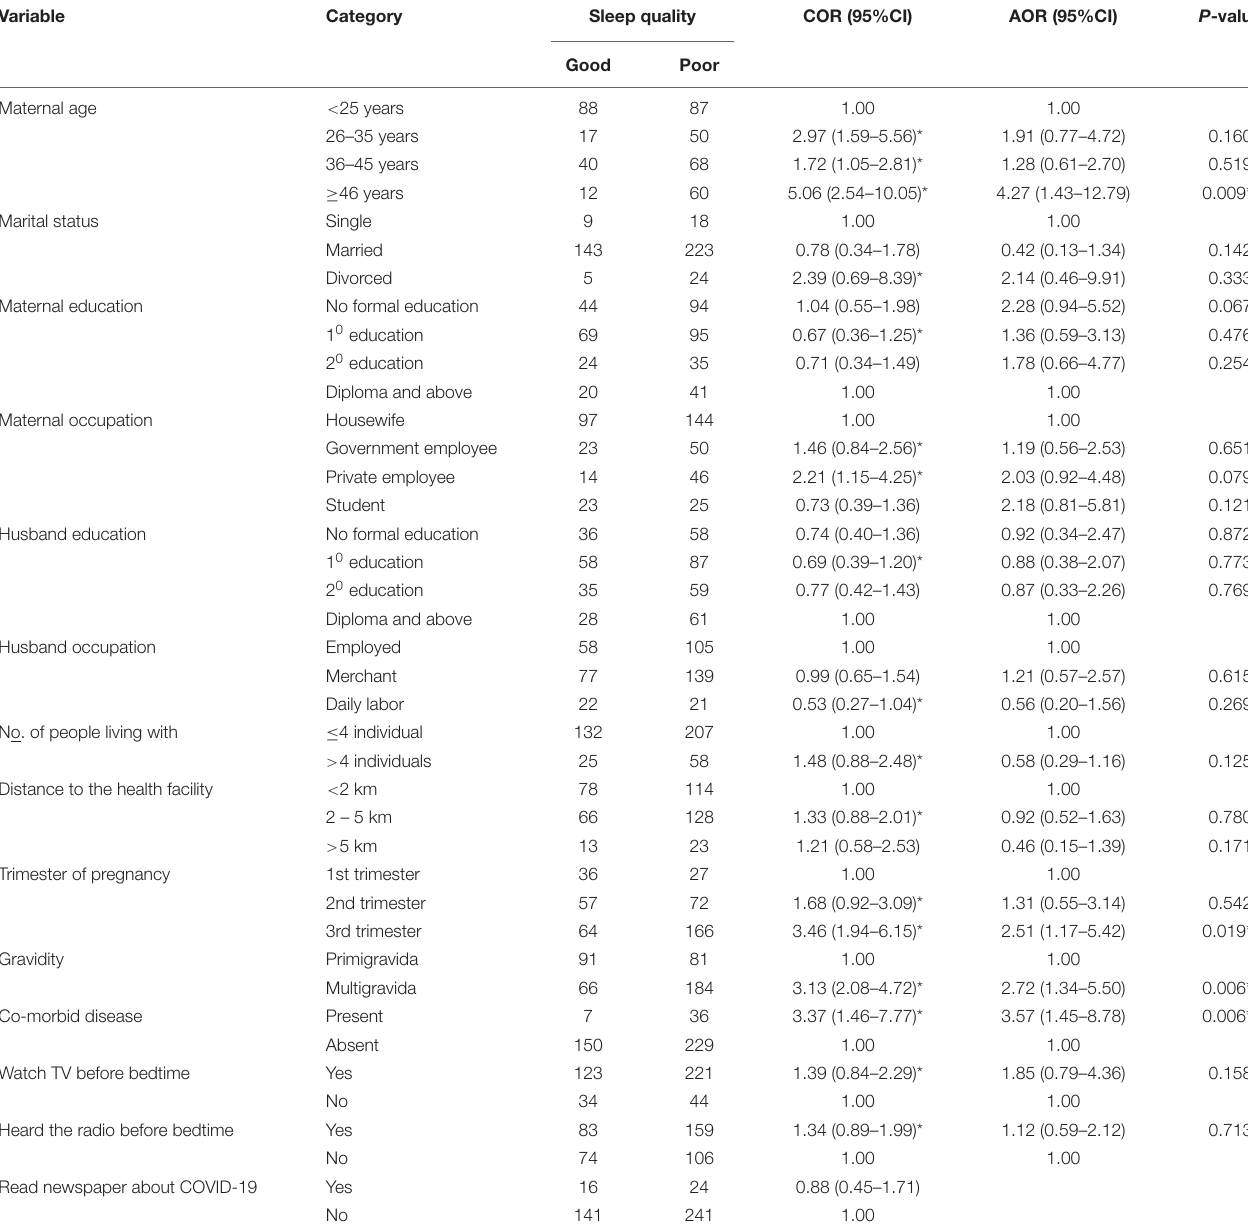
TABLE 2 | Bivariate and multivariate sleep quality analysis among pregnant women in Debre Berhan ( n = 422). Variable